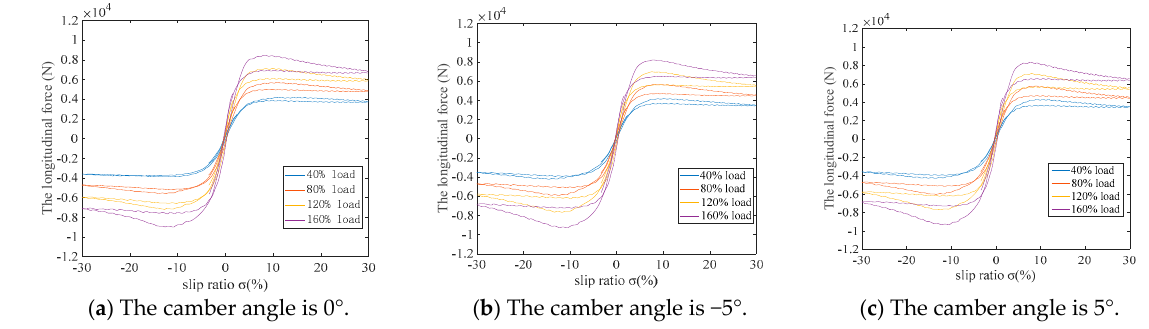
Figure 4. Longitudinal force experiments with different camber angles.